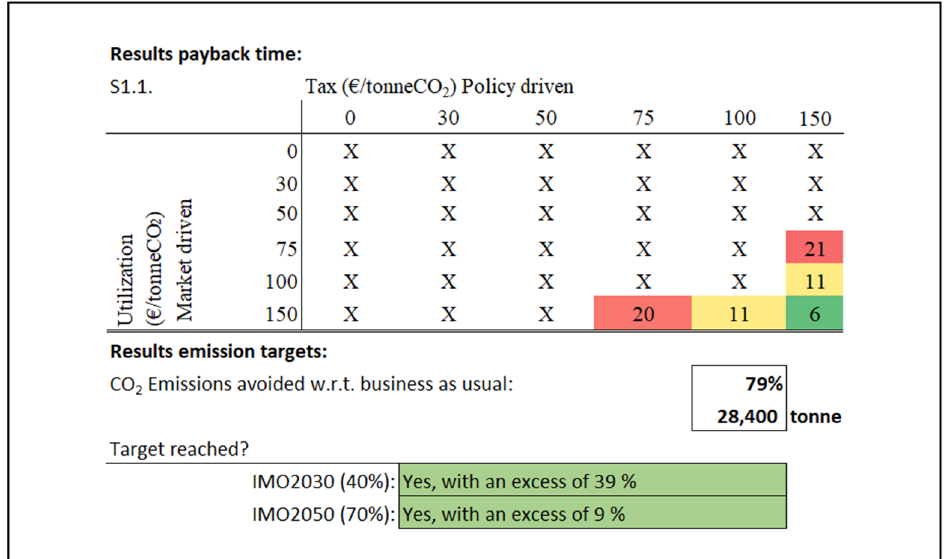
Figure 3. Results scenario 1.1. Payback time in years. Conditions marked with an X have a payback time >30 years, which equals the typical lifetime of a vessel.